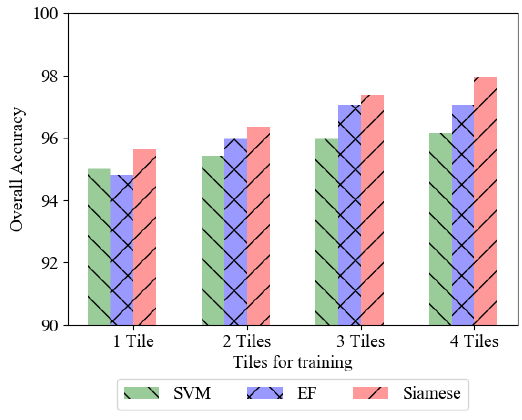
Figure 6. Overall Accuracy from each method using 1, 2, 3 and 4 Tiles for